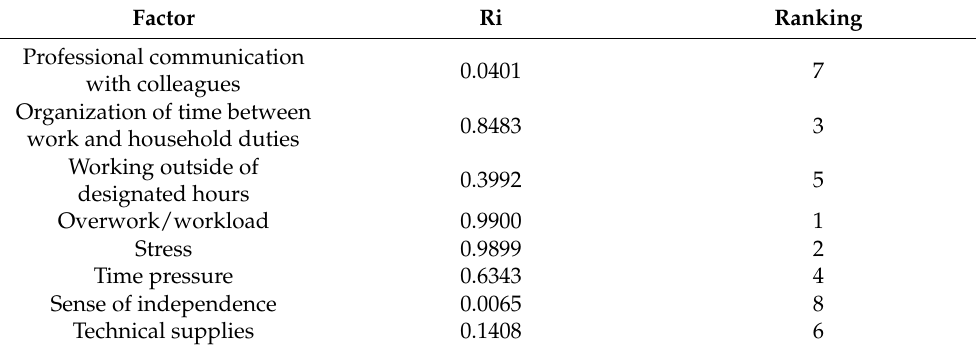
Table 10. Determination of the ranking